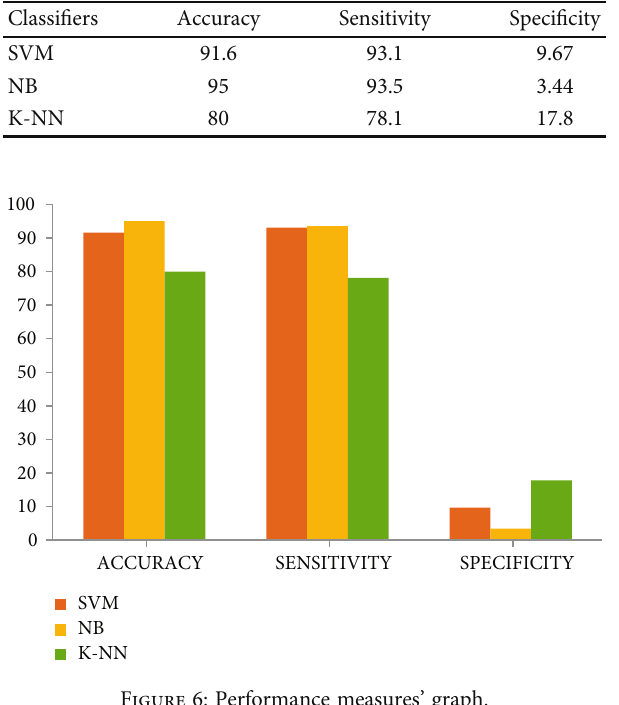
Figure 6: Performance measures ’